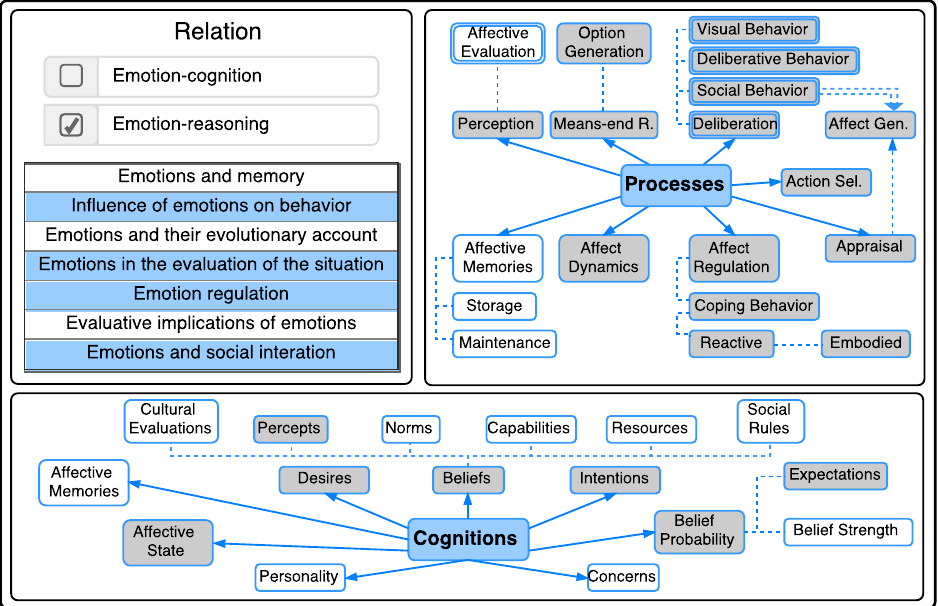
Figure 10. Processes and cognitions of the computational model of